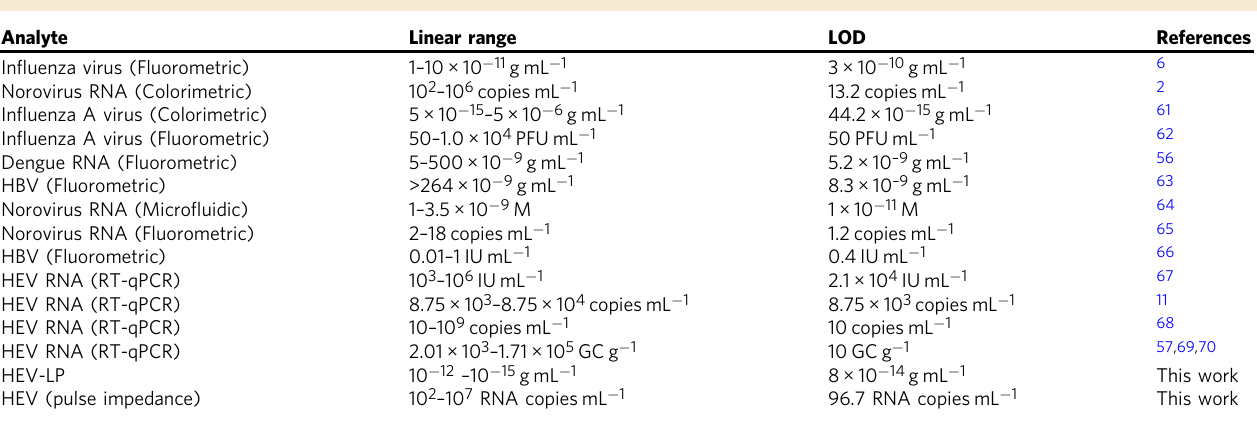
Table 1 Comparison with recently reported virus detection